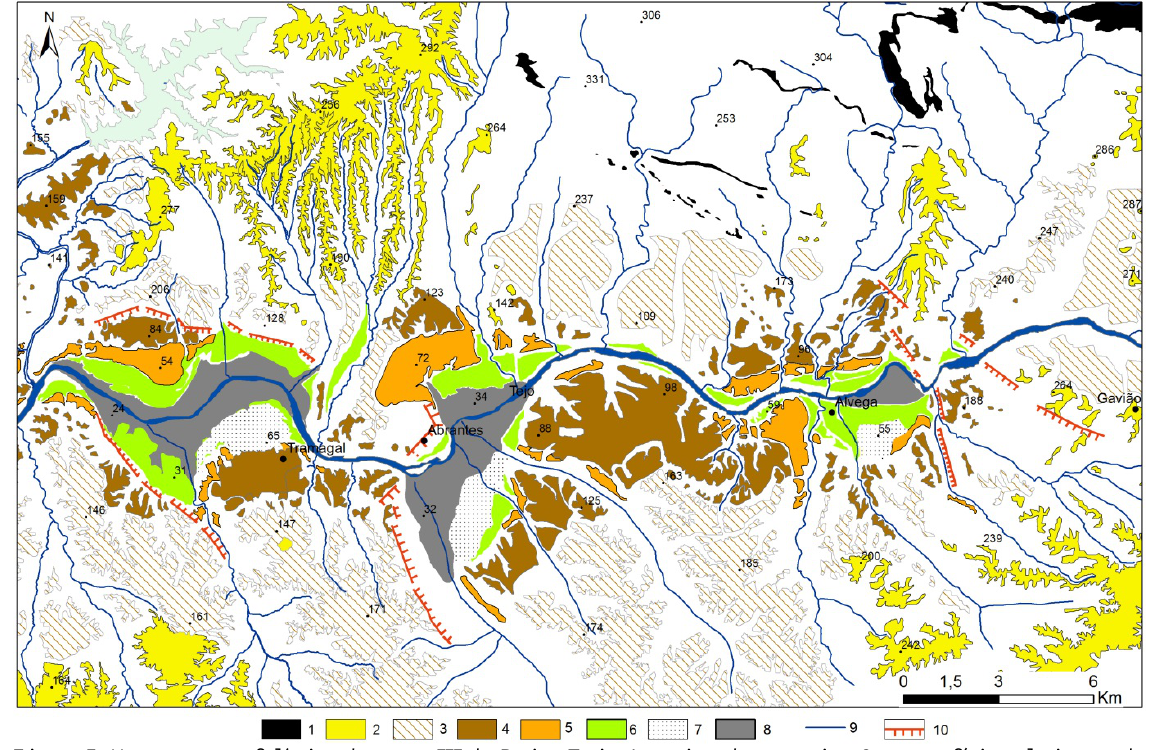
Figura 5. Mapa geomorfológico do troço III do Baixo Tejo. 1 - crista de quartzito; 2 - superfície culminante do enchimento sedimentar da Bacia Cenozóica do Baixo Tejo; 3 - nível de erosão N1; 4 - terraços superiores (T1, T2 e T3); 5 - terraço T4; 6 - terraços inferiores (T5 e T6); 7 - cobertura de areias eólicas; 8 - planície aluvial (Holocénico); 9 - curso de água; 10 - escarpa de falha. Figure 5. Geomorphological map of the reach III in the Lower Tejo. 1 - quartzite ridge; 2 - culminant surface of the sedimentary infill of the Lower Tejo Cenozoic Basin; 3 - N1 erosion surface; 4 - upper terraces (T1, T2 and T3); 5 - T4 terrace; 6 - lower terraces (T5 and T6); 7 - aeolian sands; 8 - alluvial plain (Holocene); 9 - stream; 10 - fault